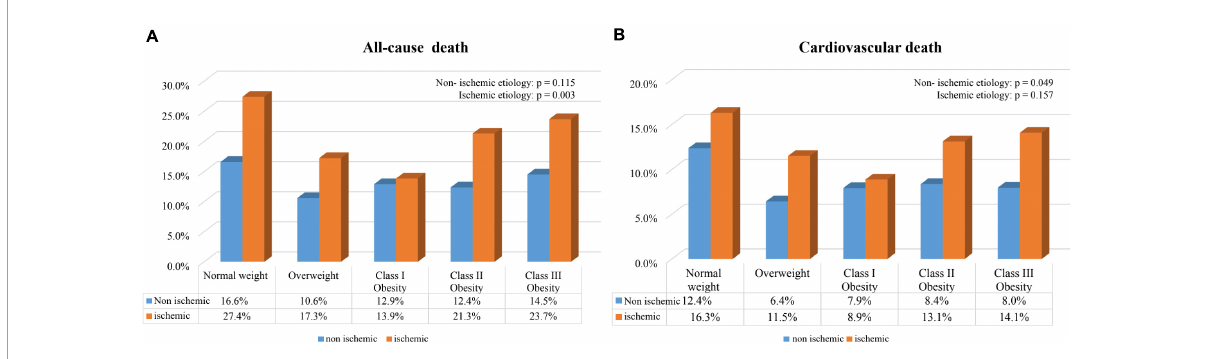
FIGURE1 Crude death rates in HFpEF patients with non-ischemic and ischemic etiology according to baseline BMI categories. (A) All-cause death; (B) cardiovascular death.